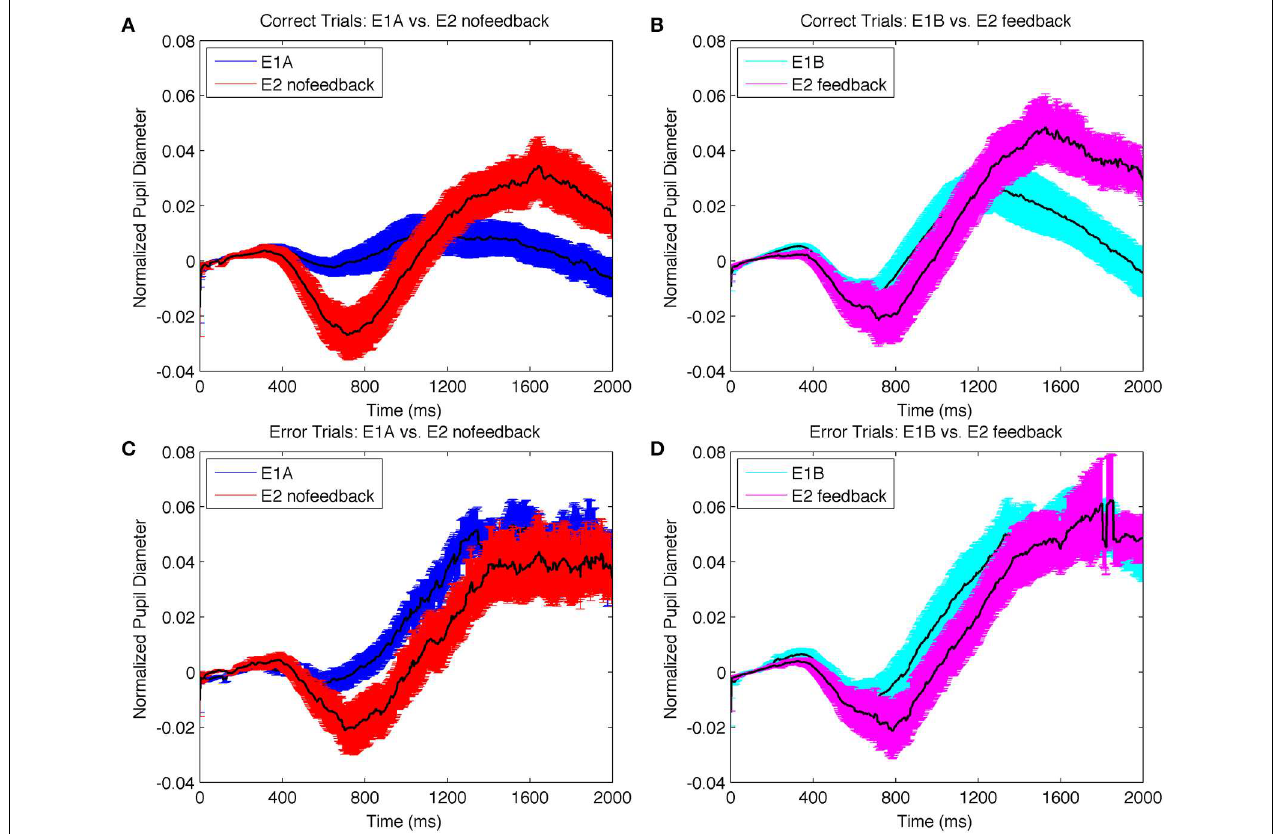
FIGURE 7 | Change in normalized pupil diameter on correct trials plotted together for: (A) E1A and E2 nofeedback (B) E1B and E2 feedback ; and on error trials for (C) E1A and E2 nofeedback (D) E1B and E2 feedback . The difference between